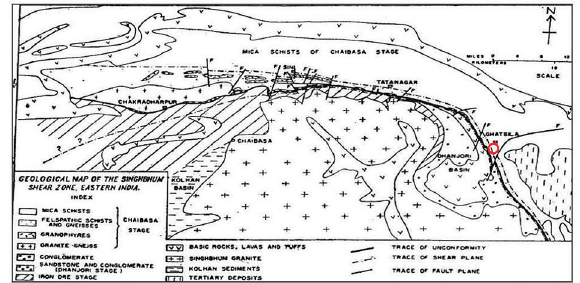
Fig. 2. Study area marked as red circle in the geological setup of the Singhbhum Shear zone (after Mukhopadhyay